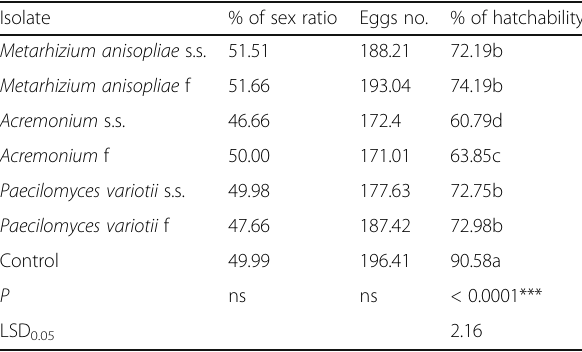
Table 3 Effect of some fungal isolates on sex ratio, fecundity, and fertility of spiny bollworm Earias